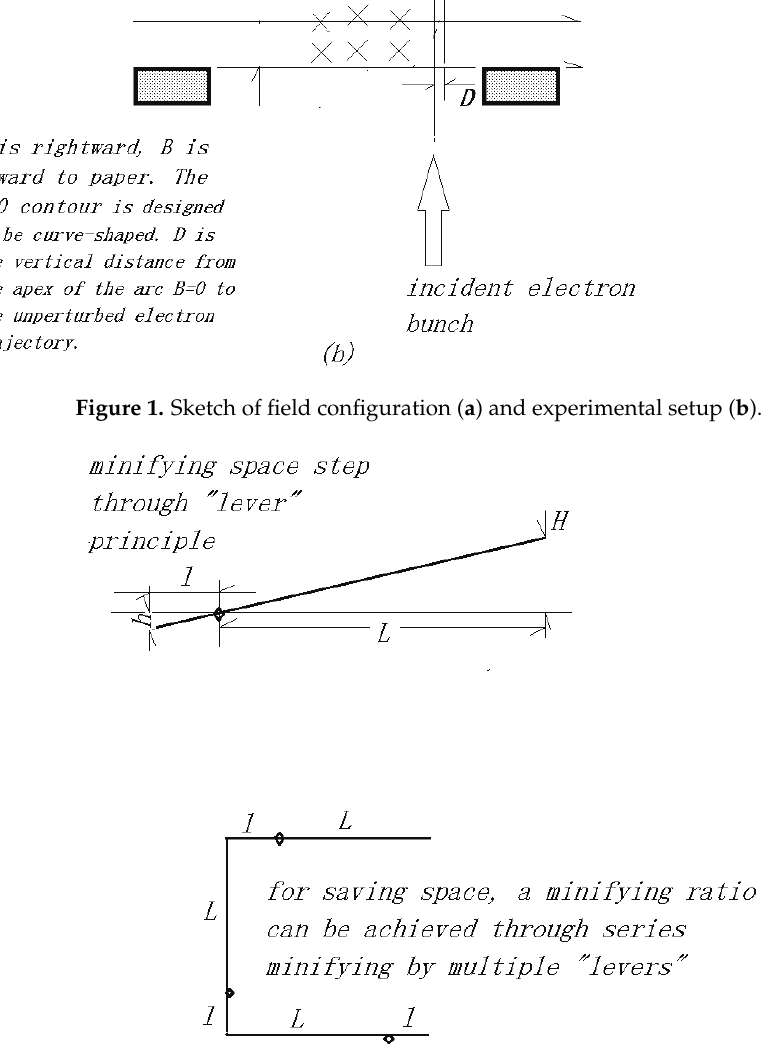
Figure 2. Sketch of the device for minifying space